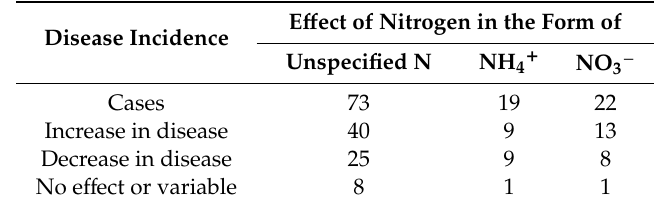
Table 1. Number of published papers reporting the e ff ects of nitrogen nutrition on plant disease